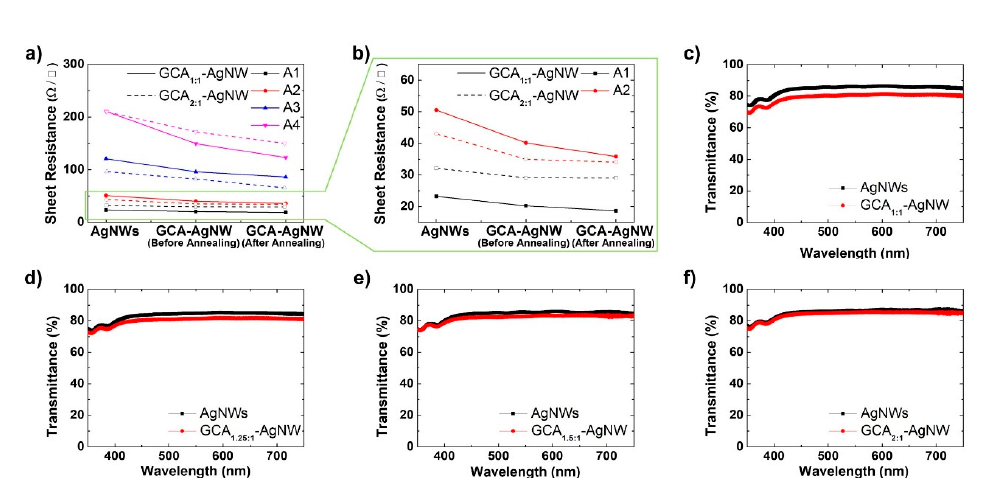
Figure 5. Sheet resistance and transmittance of AgNWs and GCA–AgNW. ( a ) Sheet resistance of all samples and the ( b ) sheet resistance of A1 and A2 group samples; ( c – f ) optical transmittance of AgNWs and GCA 1:1 –AgNW, AgNWs and GCA 1.25:1 –AgNW, AgNWs and GCA 1.5:1 –AgNW, and AgNWs and GCA 2:1 –AgNW, respectively.